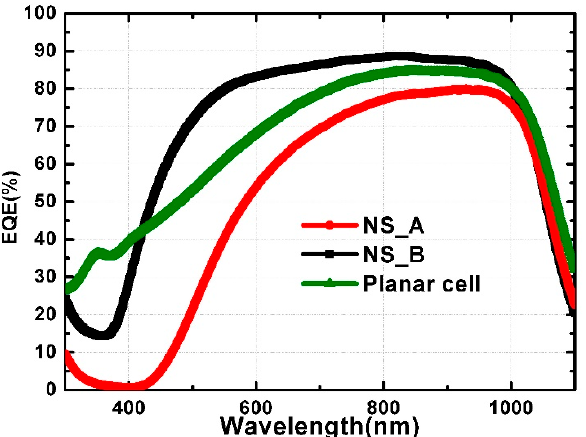
Figure 9. The quantum efficiency of three groups of cells after LIP. NS-B cells showed the best per-